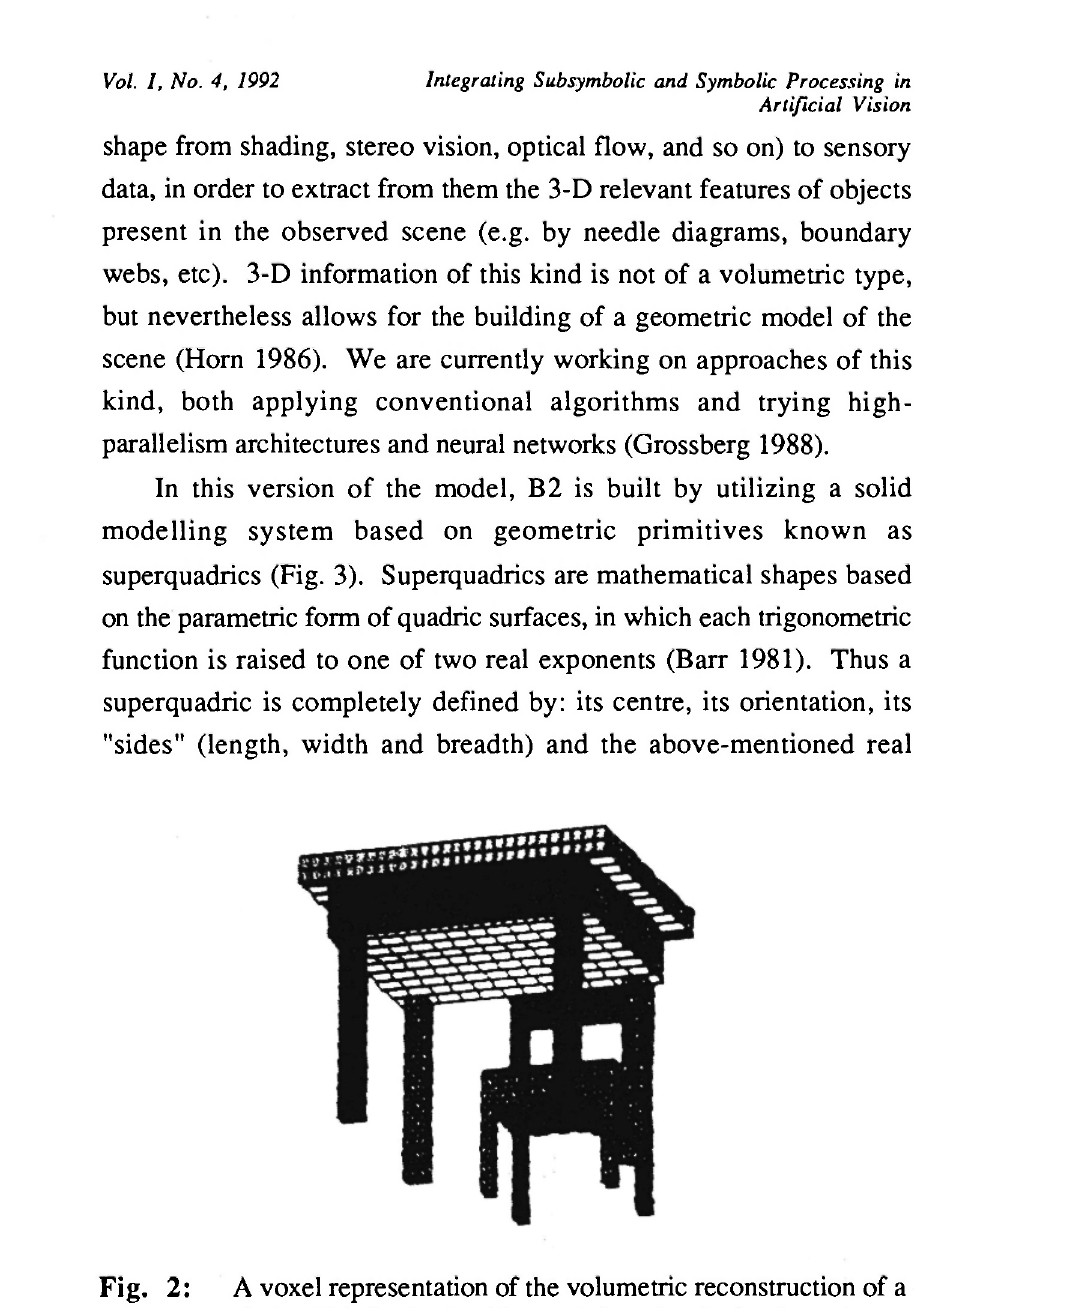
Fig. 2: A voxel representation of the volumetric reconstruction of a chair. This is obtained by applying classical volume inter- section techniques to infinite generalized cylinders grown up from silhouettes from 2-D digital images representing views of the observed